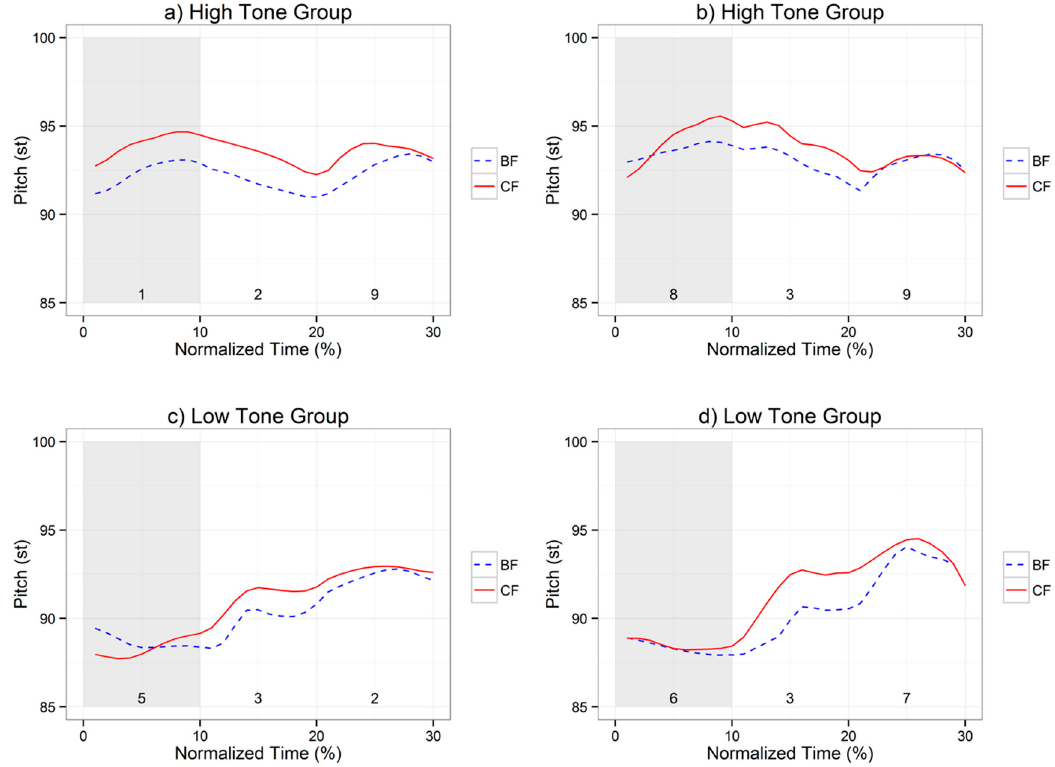
Figure 4. Sample pitch contours for the low and high tone groups in the two focus conditions. In panels ( a , b ), the digits highlighted in gray belong to the high tone groups, and in panels ( c , d ), the digits in the first area refer to the low tone groups. BF and CF are abbreviations for broad focus and corrective focus, respectively.